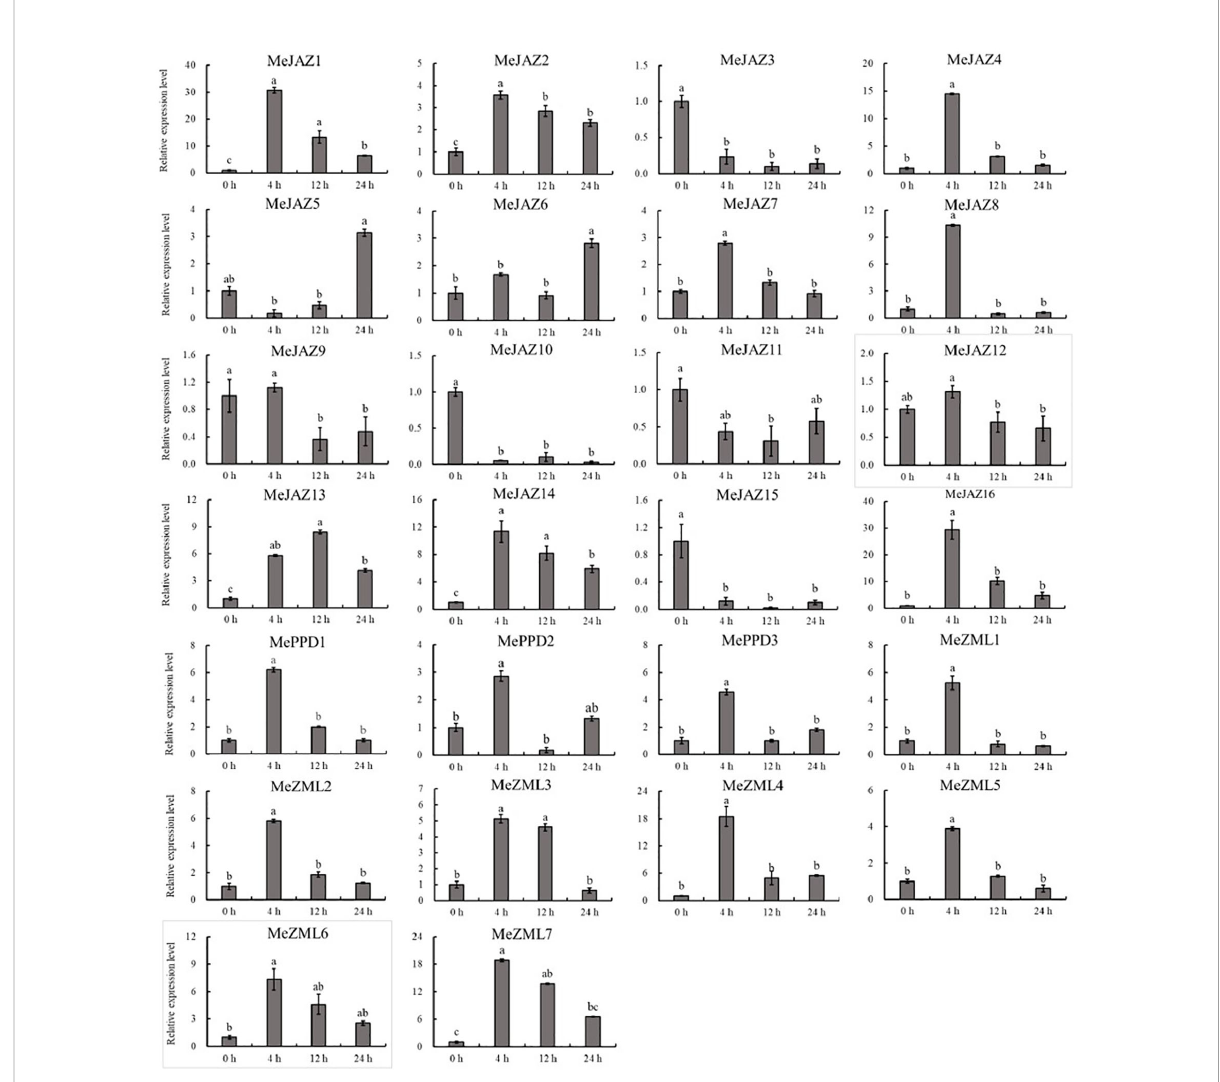
FIGURE 9 Expression pro fi les of 26 ZML , PPD and JAZ genes in response to salt stress in cassava as determined by qRT-PCR. The error bars represent the standard error of the means of three independent replicates. Values denoted by the same letter did not differ signi fi cantly at P < 0.05 according to Duncan ’ s multiple range